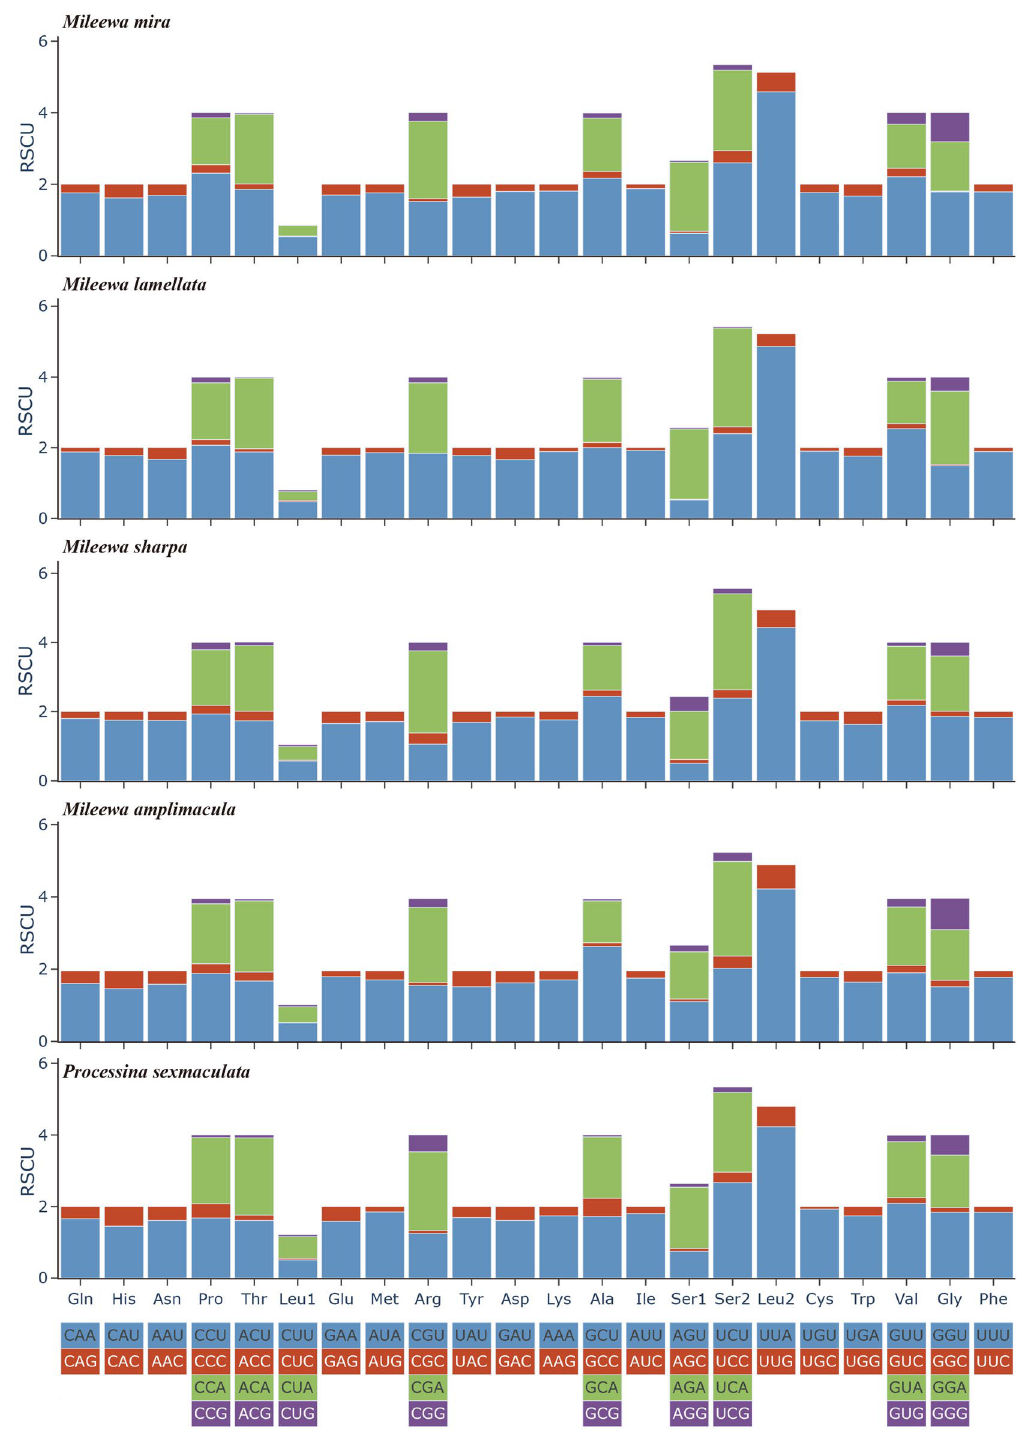
Figure 2. Relative synonymous codon usage (RSCU) values in protein-coding genes (PCGs) of the four Mileewa and one Processina species